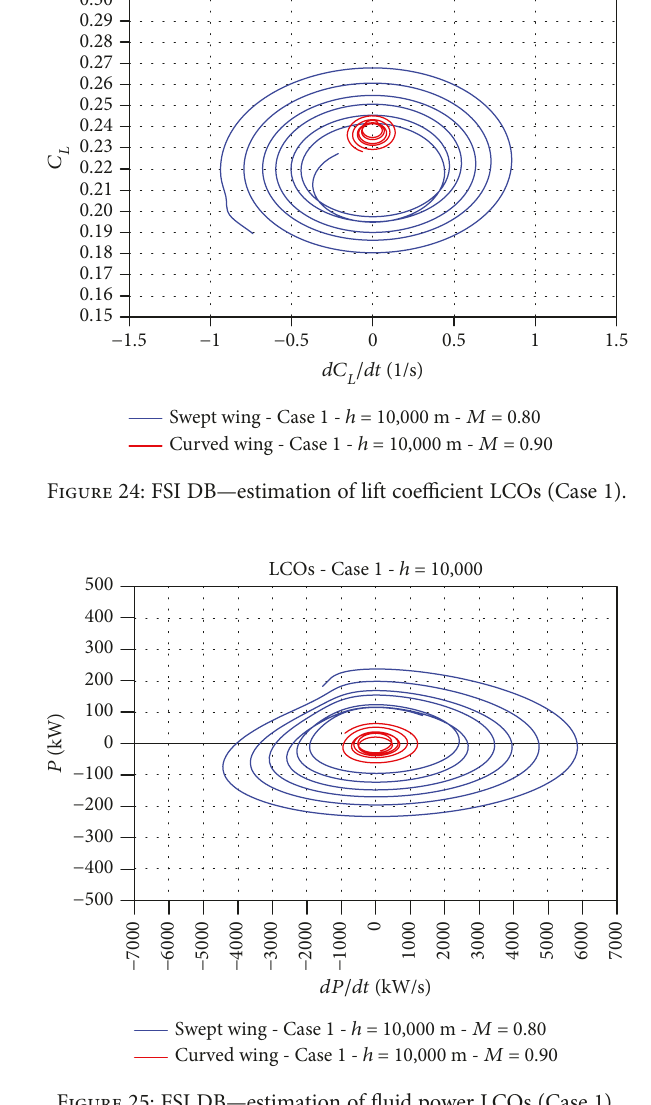
Figure 23: FSI DB — estimation of curved-wing tip displacement LCOs (Case 1 — cruise [20]).